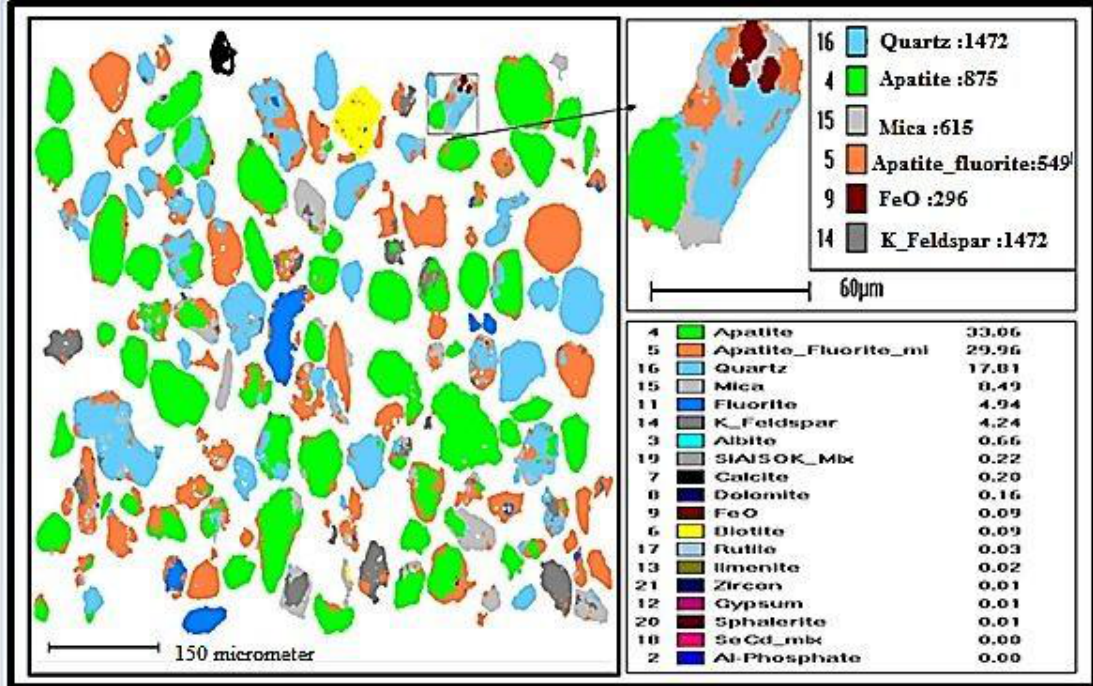
Figure 5. Classified MLA image of flotation feed (74 × 37 µ m 2 ) showing mineral associations in the grains. Particle inset units are in pixels concentration palette values are in area percentage.